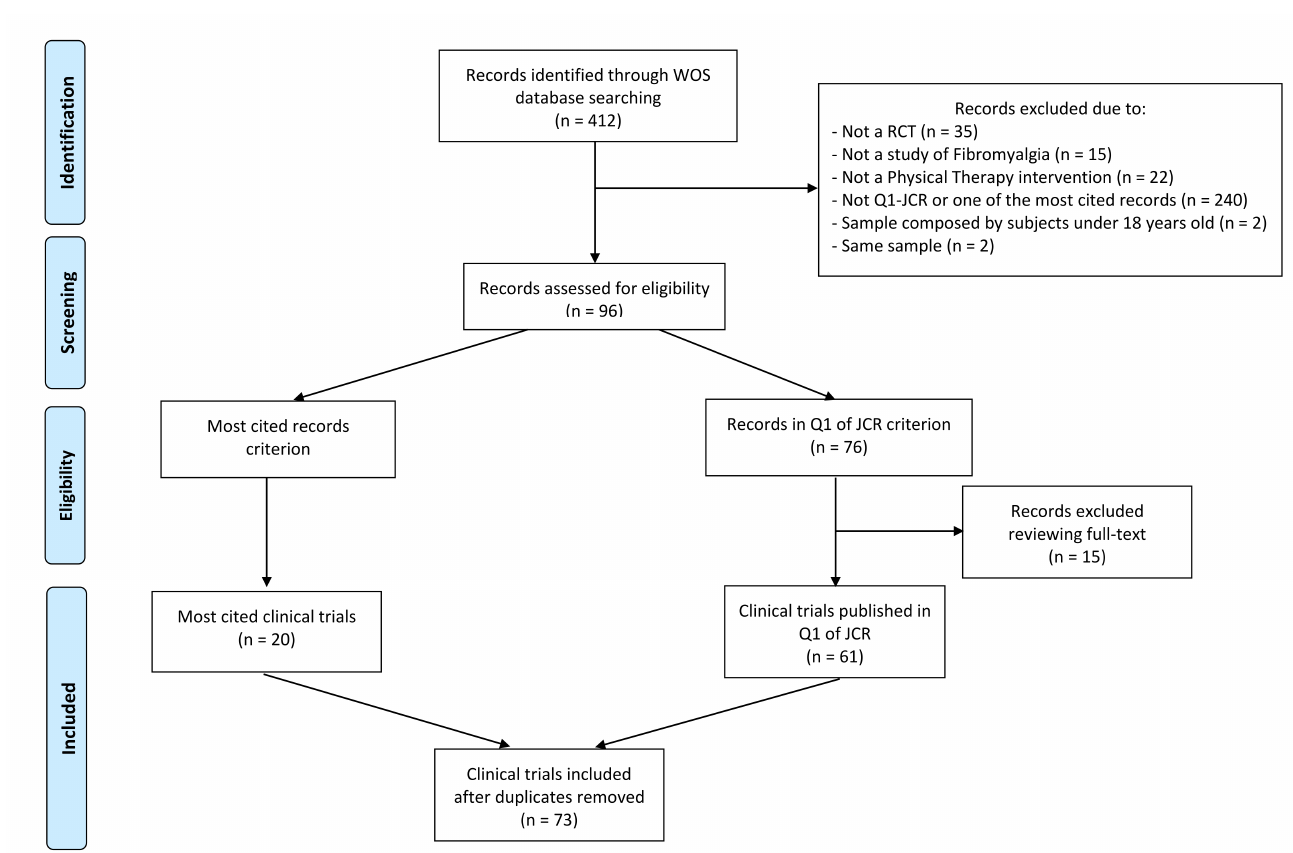
Figure 1. PRISMA extension for scoping reviews (PRISMA-ScR) flow diagram. WOS: Web of Science; RCT: randomized clinical trial; JCR: Journal Citation Reports.